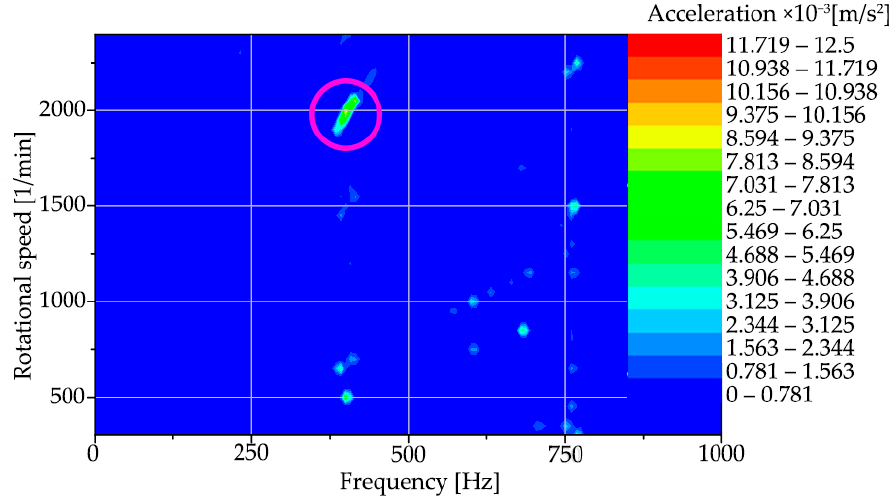
Figure 16. Frequency and speed map for machine start-up with the resonance region marked.